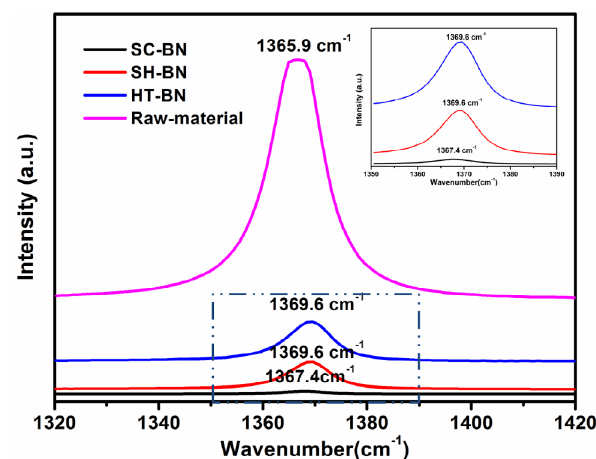
Fig. 7 Raman spectra of exfoliated BNNS by different methods.